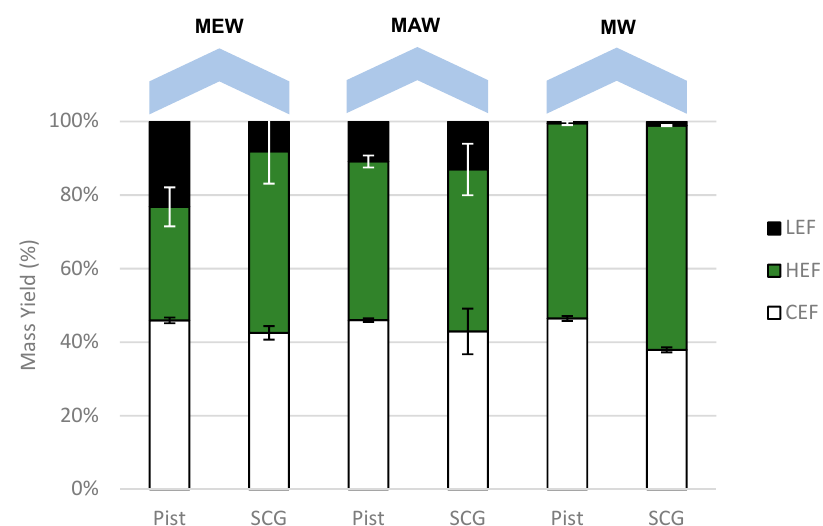
Figure 1. Cellulose-enriched fraction (CEF), hemicellulose-enriched fractions (HEF) and lignin-enriched fraction (LEF) yields obtained in the six different types of fractionation with two feedstock (pistachio hull and spent coffee grounds, SCG) and three solvent systems (MEW—MIBK, ethanol and water; MAW—MIBK, acetone and water; MW—MIBK and water).